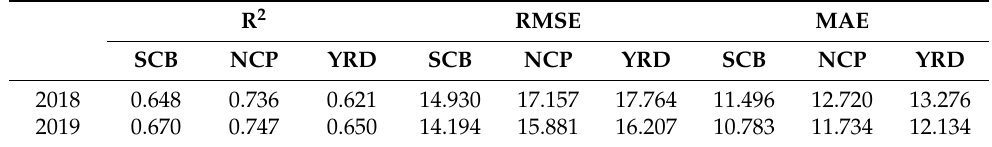
Table 3. The R 2 values, RMSE, and MAE during years 2018–2019 over the SCB, NCP, and YRD.